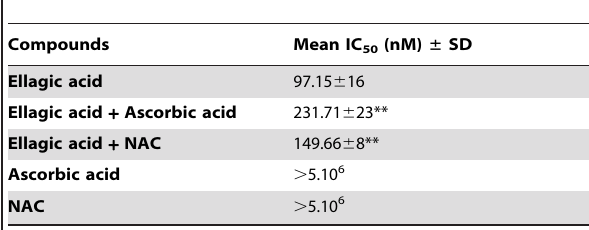
Figure 1. ROS generation in Plasmodium falciparum was detected by DCFDA probe. All parasitized erythrocytes were labeled with DCFDA for 30 minutes. After washing, they were incubated for 3 hours with or without ellagic acid, ascorbic acid and NAC, alone and in combination. The level of ROS in the parasites was detected by DCF- dependent measurements. The data represent the mean 6 SEM of four different experiments with triplicate sets in each assay. In the first column ( A ), the fluorescence intensity in parasites without ellagic acid is represented. The black band (control value) corresponded to the fluorescence intensity in untreated parasites incubated 3 hours. The grey and white bands corresponded to the fluorescence intensity in parasites only treated with NAC (857.10 2 6 M) and ascorbic acid (113.10 2 6 M) respectively. In the next four columns, the black bands are the fluorescence of parasites after treatment with various concentrations (between 6.61 6 10 2 9 and 6610 6 10 2 9 M) ellagic acid alone. The grey and white bands correspond to the ellagic acid treatment with NAC and ascorbic acid respectively with the same concentrations as in the first column. **p , 0.01 indicates a significant difference compared with the untreated parasites. The quantity amount of ROS was compared according to the increased of EA concentration, ## p , 0.05 indicates the significant difference. doi:10.1371/journal.pone.0045906.g001 PLOS ONE |